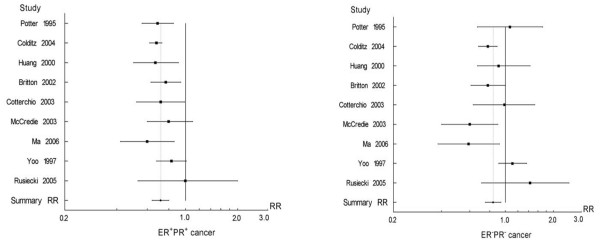
Age at menarche and breast cancer risk by estrogen receptor/progesterone receptor (ER/PR) status: relative risk (RR) with corresponding 95% confidence interval for oldest versus youngest age at menarche category.